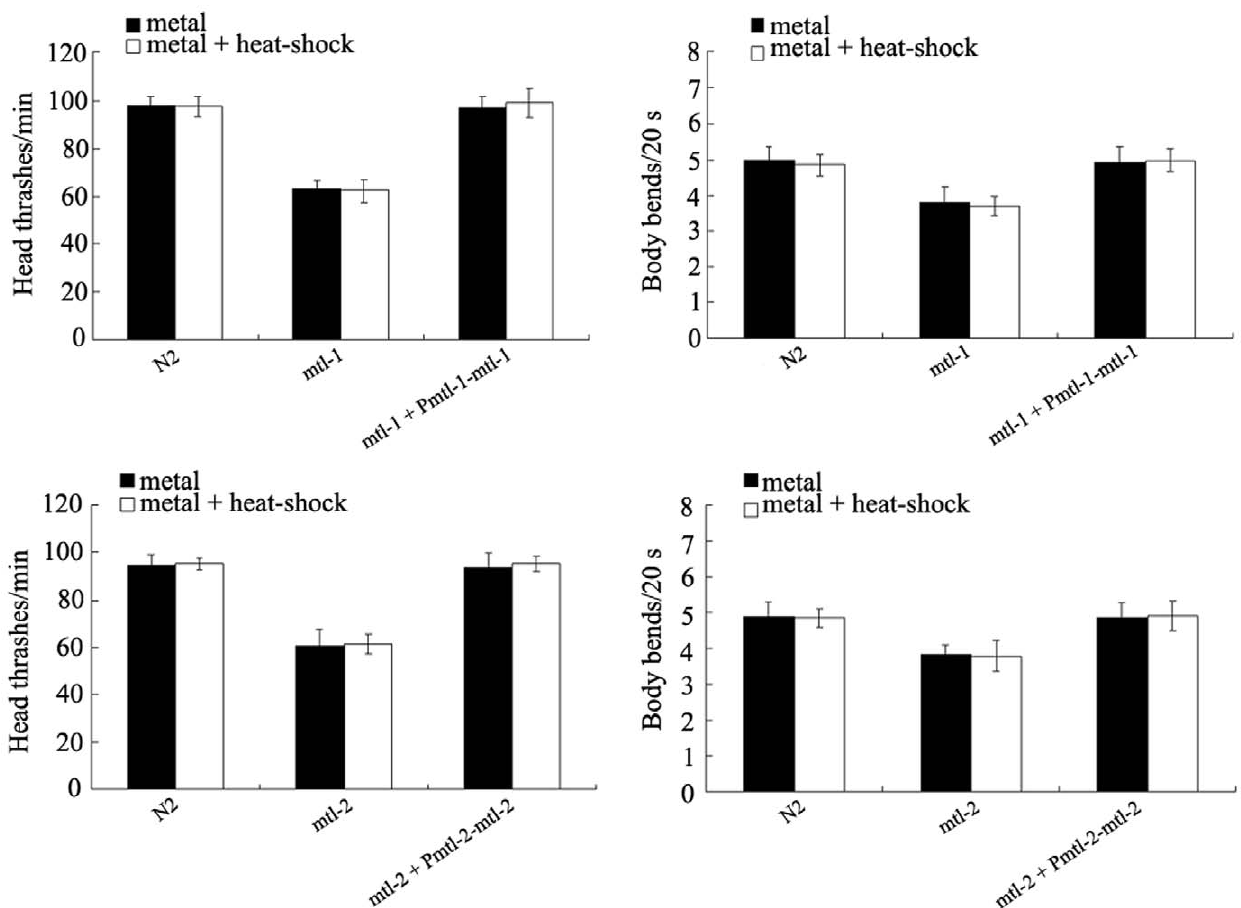
Figure 8. The defects of adaptive response to neurobehavioral toxicity induced by exposure to 200 m M of Pb in mtl-1(tm1770) and mtl-2(gk125) mutants can not be rescued by the expression of mtl-1 and mtl-2 with their native promoters. L2-stage larvae animals were heat stressed for 1 h at 36 u C. The plasmids were injected as a mix at 20 ng/ m l using P dop-1::rfp as a transgenic marker. Bars represent means 6 S.D.